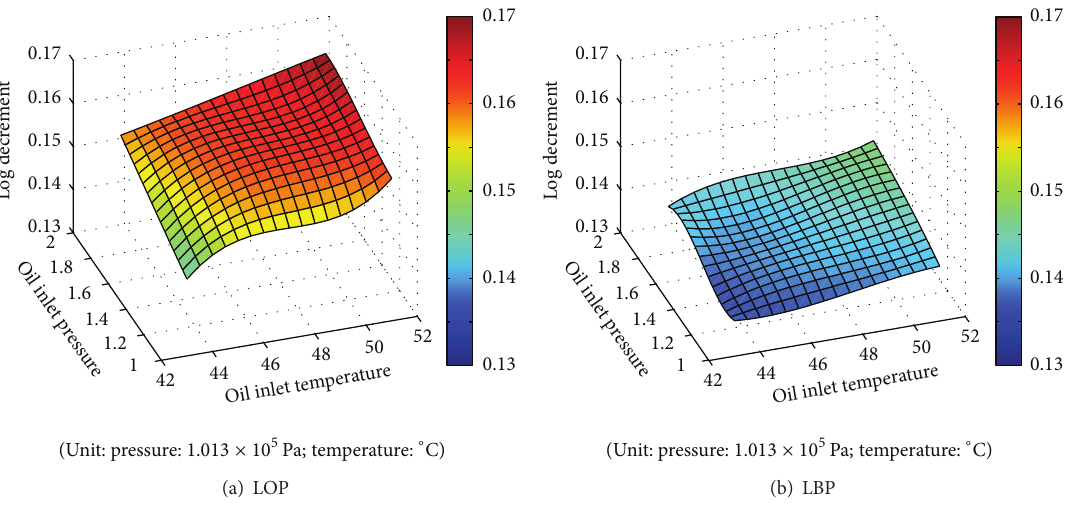
Figure 12: Log decrement of rotor-bearing system at different oil inlet temperature and pressure (preload